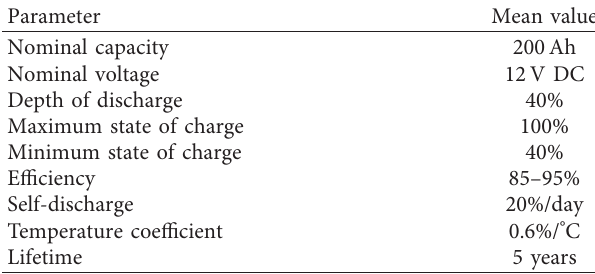
Table 3: Specifications of the lead acid batteries.